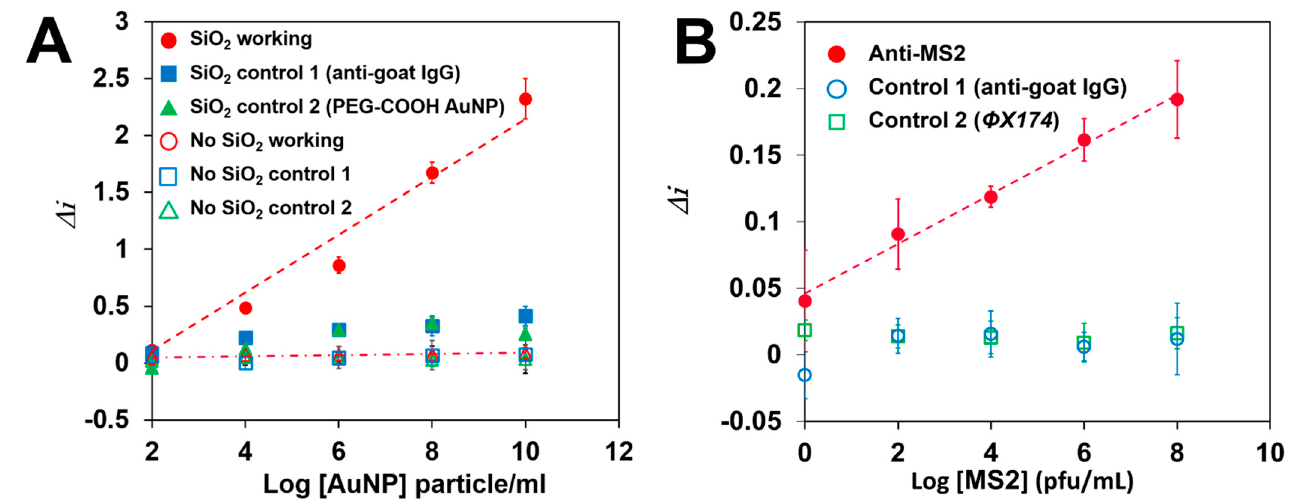
Figure 4. ( A ) Model viral particle (biotinylated gold nanoparticle) concentration response curves for the biosensors. All the markers represent the electrodes treated with silica glancing angle deposition (filled) and without silica deposition (hollow). The red circles show the results for the streptavidin-modified electrode incubated with biotinylated gold nanoparticles. The blue squares represent first control with an anti-goat IgG modified electrode incubated with biotinylated gold nanoparticles. The green triangles depict the second control with a streptavidin-modified electrode incubated with PEG-COOH coated gold nanoparticles. ( B ) MS2 bacteriophage concentration response curves for the biosensors where the red circles represent the biosensor modified with anti-MS2 antibodies; and the blue hollow circles represent the first control where the electrode was modified with anti-goat IgG. The green hollow squares show the second control where the electrode was modified with anti-MS2 antibody and incubated with Φ X174 . Differential pulse voltammetry measurements were performed by sweeping the potential from 0 to 0.6 V at 0.1 V/s in a 2 mM K 4 [Fe(CN) 6 ] and 2 mM K 3 [Fe(CN) 6 ] solution prepared in 0.1 M PBS.